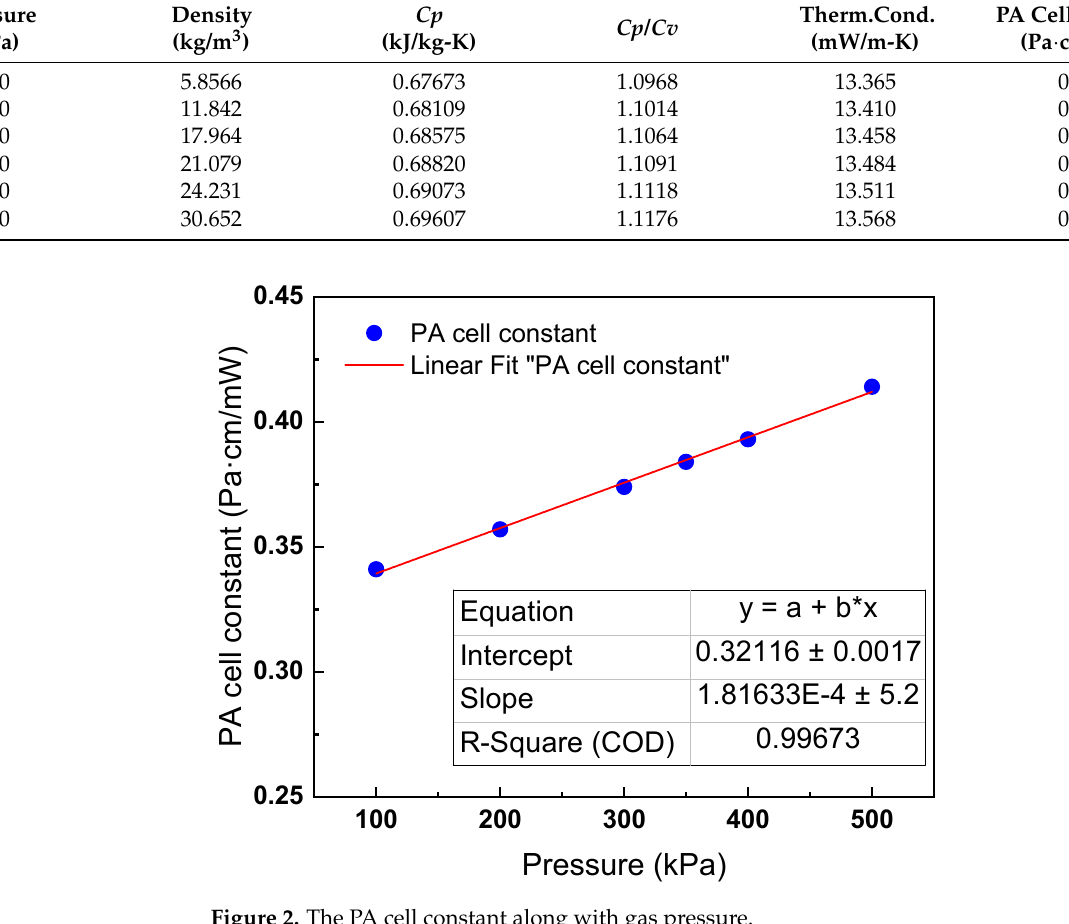
Figure 2. The PA cell constant along with gas pressure.